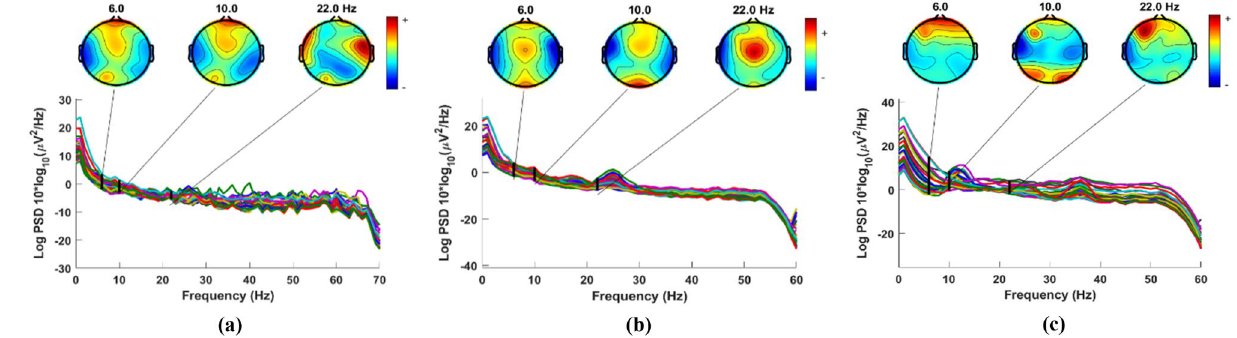
Figure 3. Power spectral density and electrode map for ( a ) Off-PD EEG ( b ) On-PD EEG ( c ) HC EEG 35